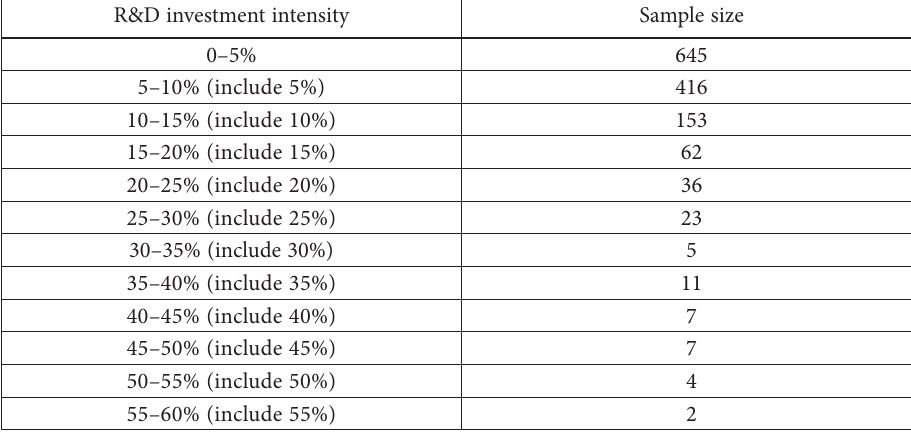
Table 2. The frequency distribution of R&D investment to operating